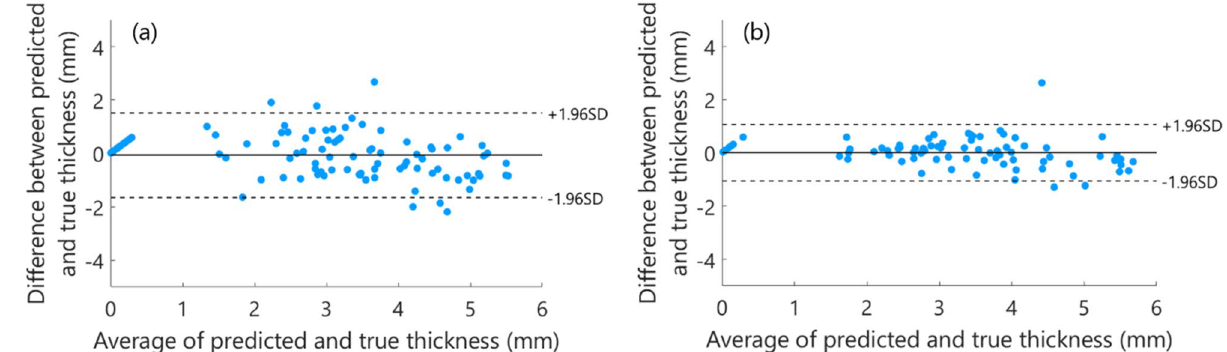
Figure 8. Bland–Altman plots of the agreement between reference values (ground truth) and predicted top layers thicknesses, using the peak-based DRS features and the GPR model, for (a) fat on top of muscle tissue and (b) muscle on top of fat tissue. The black line shows the mean difference between the predicted and true layer thickness, the dashed lines show the 95% confidence interval for the agreement (± 1.96SD).